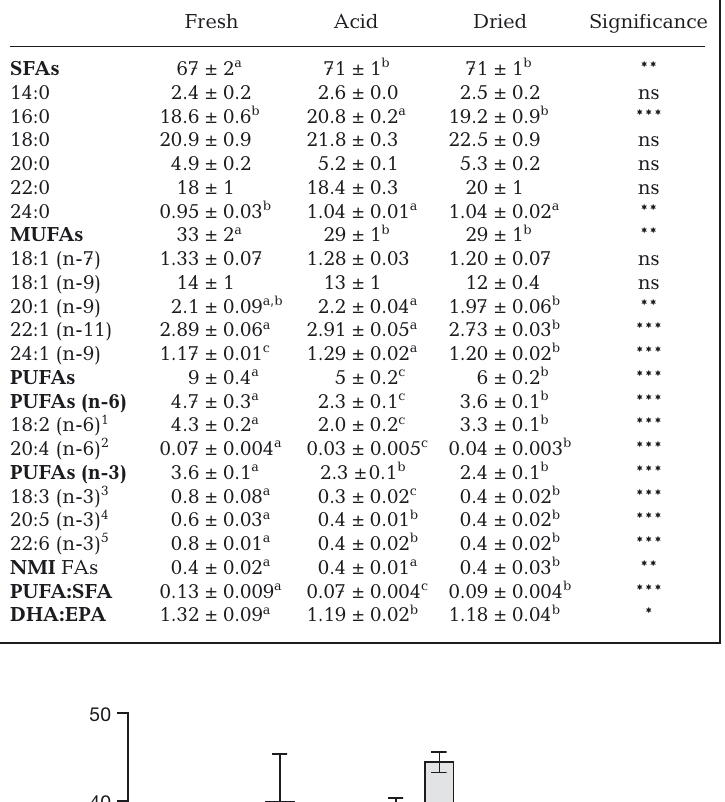
Table 3. FA composition (% of total FAs) of the diets (defined in Table 1). Only FAs contributing >1% of the total FAs are considered here, as well as 1 linoleic acid, 2 arachidonic acid, 3 α -linolenic acid, 4 eicosapentaenoic acid and 5 docosahexaenoic acid. All FAs (>0.1% of total FAs) were used to calcu- late the sum of saturated, monounsaturated and polyunsaturated FAs (SFAs, MUFAs and PUFAs), n-6 and n-3 PUFAs or non-methylene interrupted